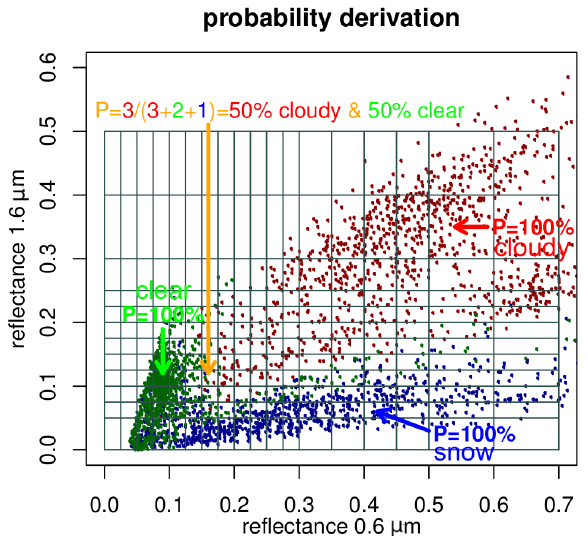
Fig. 2. Schematic graph presenting the concept of probability derivation in the PCM algorithm based on the two-dimensional spectral space composed of the reflectances at 0.6 and 1.6µm. In the equation P denotes probability and numbers denote the counts of cloudy, clear and snow pixels within a bin. The samples were de- rived from the PPS and MOD10A1 classifications of the NOAA17 satellite scene acquired over the Alps on 1 January